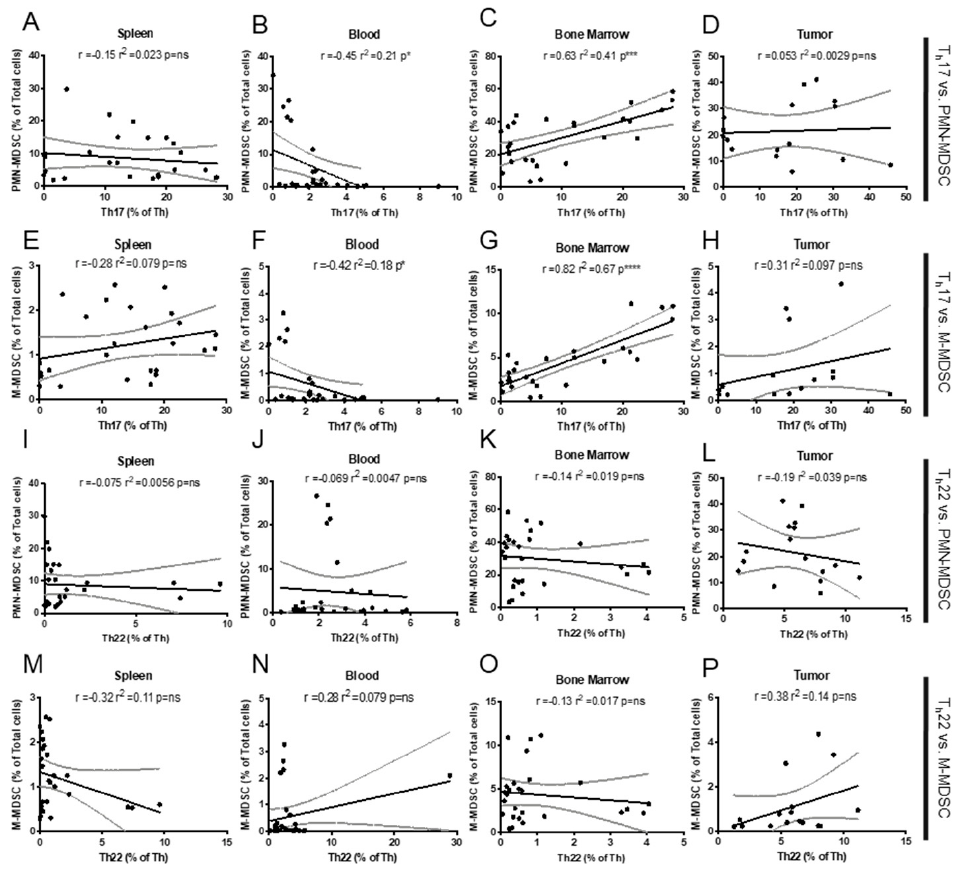
Figure 6. Correlations between type 3 T h and MDSC accumulation. Pearson correlation assessing the association between type 3 T h percentages is shown in Figure 3, and MDSC percentages are shown in Figure 5. ( A – D ) T h 17 and PMN-MDSC, ( E – H ) T h 17 and M-MDSC, ( I – L ) T h 22 and PMN-MDSC, and ( M – P ) T h 22 and M-MDSC recruitment in the spleen, blood, bone marrow, and tumor of 4T1 tumor-bearing animals. Simple linear regression included to visualize relationship and 95% CI are presented. p = ns (not significant), * p < 0.05, *** p < 0.001, and **** p <